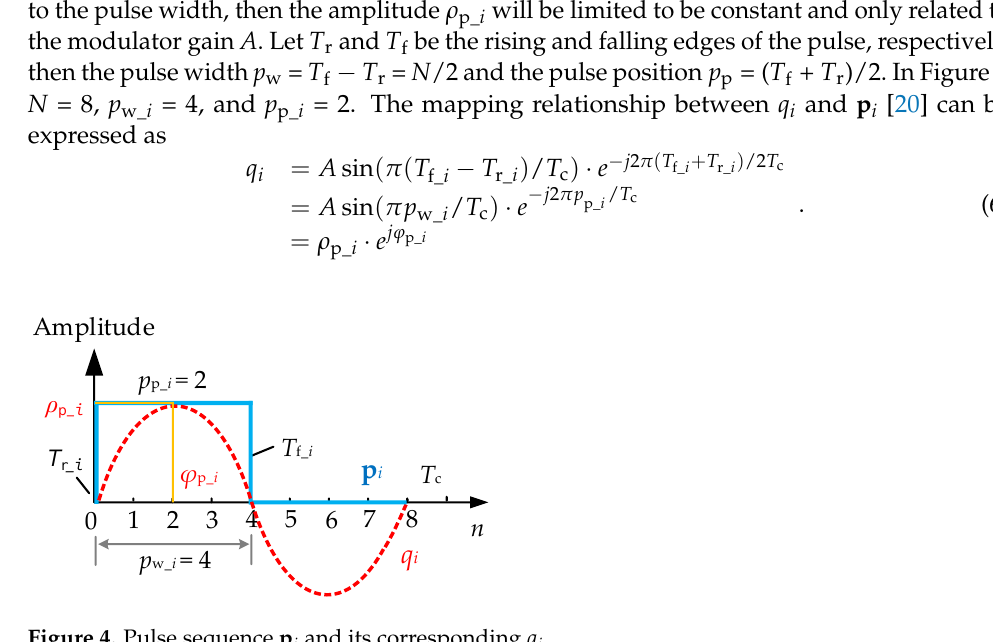
i and its corresponding q i